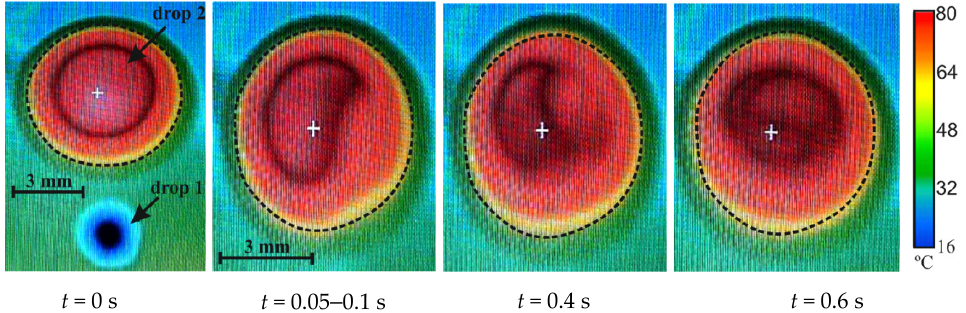
Figure 7. Thermal imager measurements of thermal field on the surface of drop 2 (water) after the fall of droplet 1 (water).